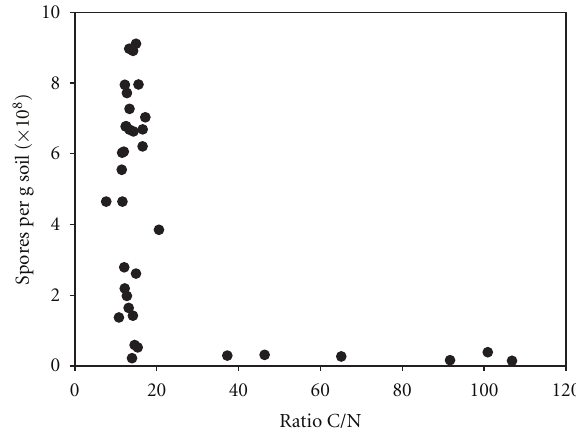
Figure 4: Spore number (expressed as equivalents of B. subtilis ) as function of soil carbon-to-nitrogen ratio.